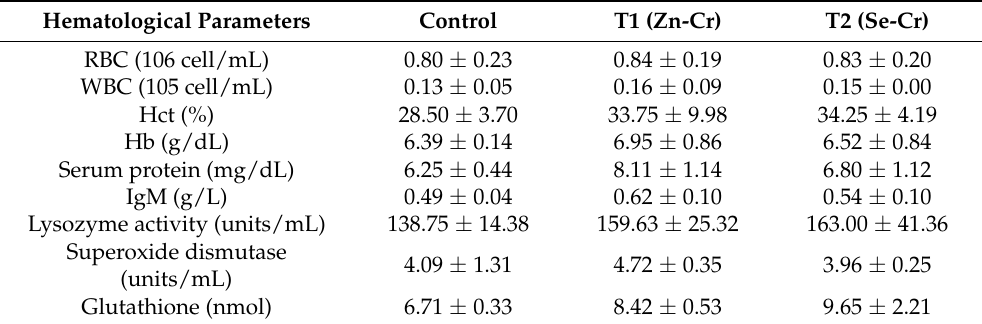
Table 4. Hematological parameters of red tilapia that were fed diets with different trace minerals for 8 weeks (mean ±